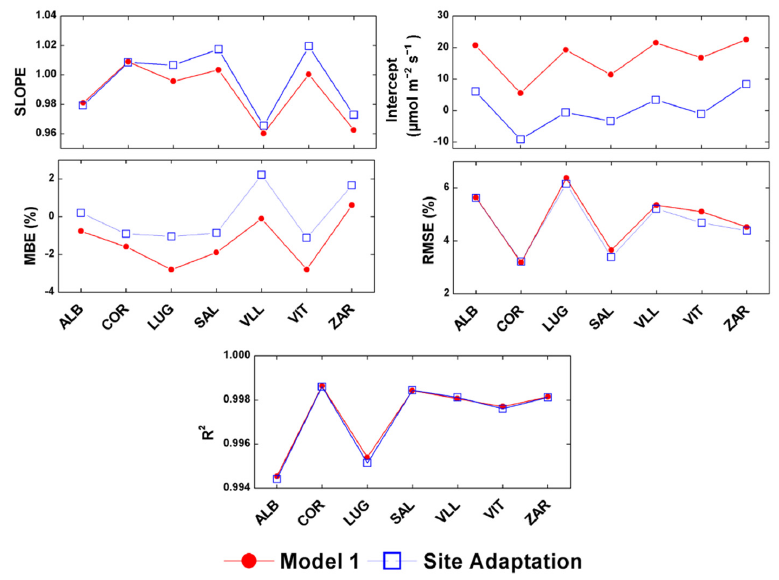
Figure 4. Comparison between the statistical results obtained by MR Model 1 and its site-adaptation correction.